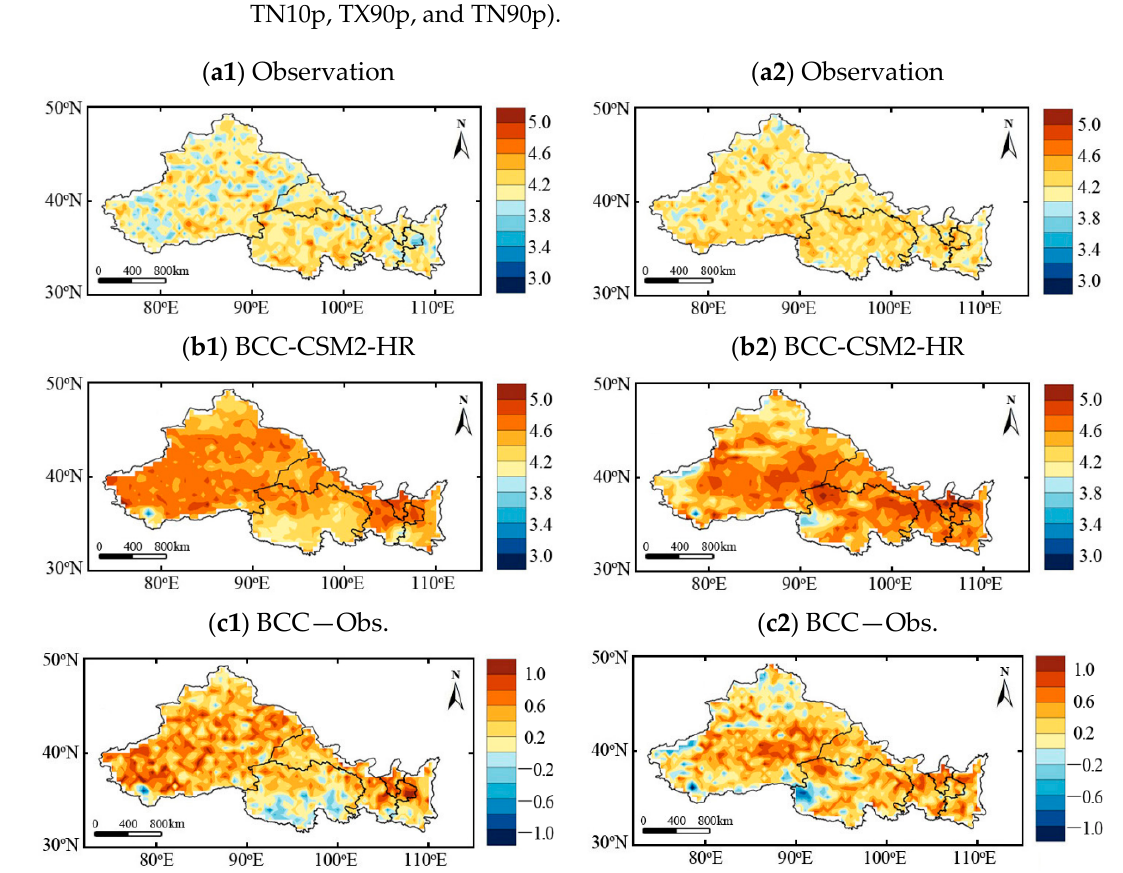
Figure 7. Spatial distribution of TX90p ( left ) and TN90p ( right ) over Northwest China during 1961–2014: observations, the values simulated by the BCC-CSM2-HR, and the difference between them. Unit: %.